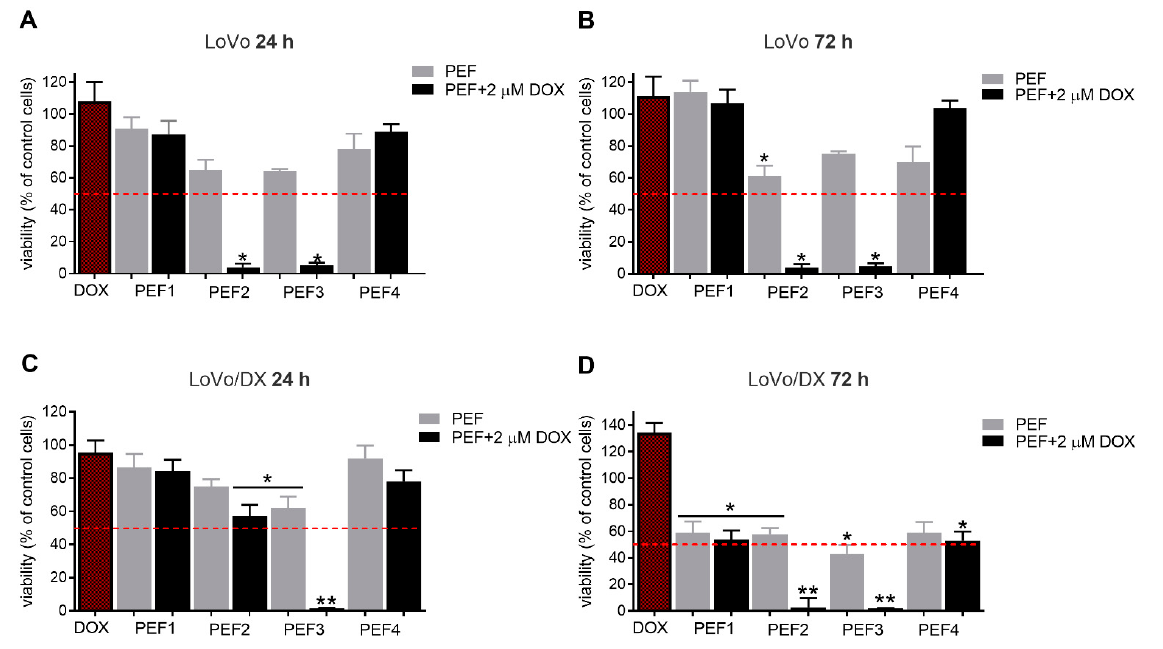
Figure 4. The viability of human colon adenocarcinoma cells exposed to electrical pulses without and with doxorubicin (DOX, C DOX = 2 µ M) after 24 h for ( A ) LoVo and ( C ) LoVoDX cells, and after 72 h for ( B ) LoVo and ( D ) LoVoDX cells. The following treatment protocols were used: PEF1—10 kV/cm × 300 ns × 200; PEF2—40 kV/cm × 20 ns × 400; PEF3—60 kV/cm × 20 ns × 400; PEF4 — 1.2 kV/cm × 100 μ s × 8 (ESOPE); red bar DOX—DOX treated only. All the data are normalized to untreated control. Asterisk (*) corresponds to ( p < 0.05) or (**) to ( p < 0.005) statistically significant difference.